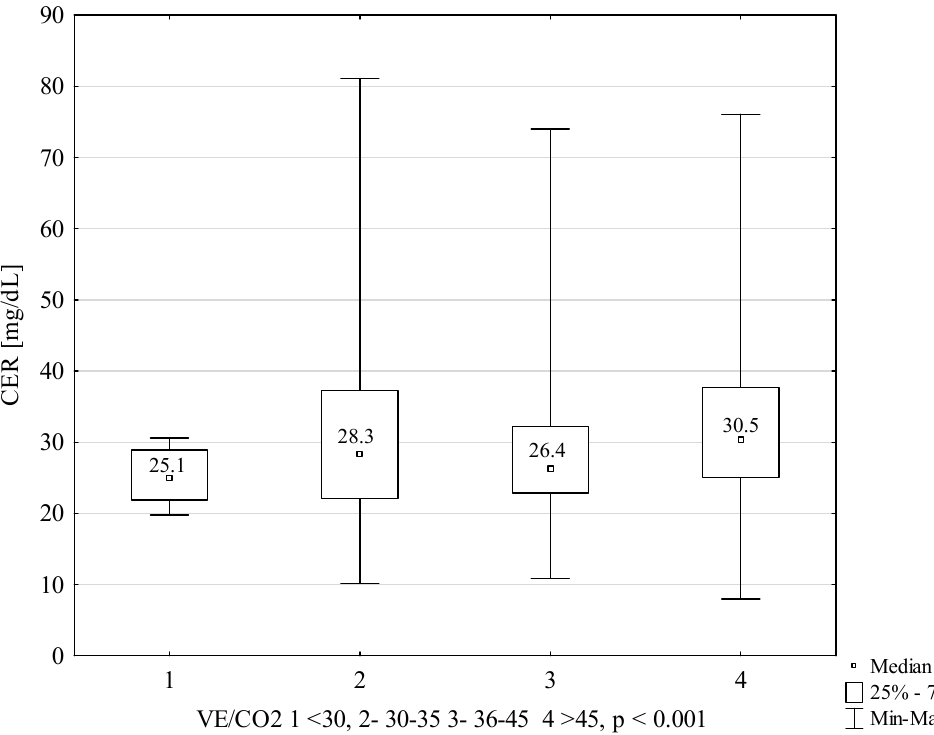
Figure 3. CER concentration in subgroups, depending on VE/VCO 2 results.